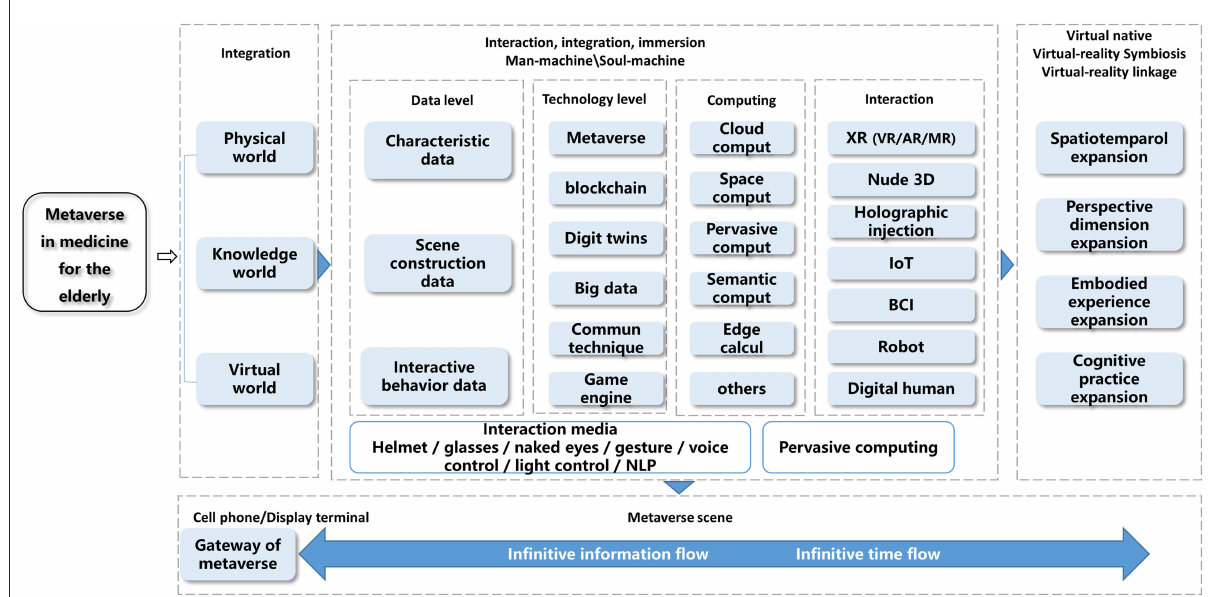
FIGURE2 Diagram of technical stratification in realizing the metaverse in medicine for the elderly. IoT, internet of things; XR, extended reality; VR, virtual reality; AR, augmented reality; MR, mixed reality; BCI, brain computer interface; and NLP, natural language